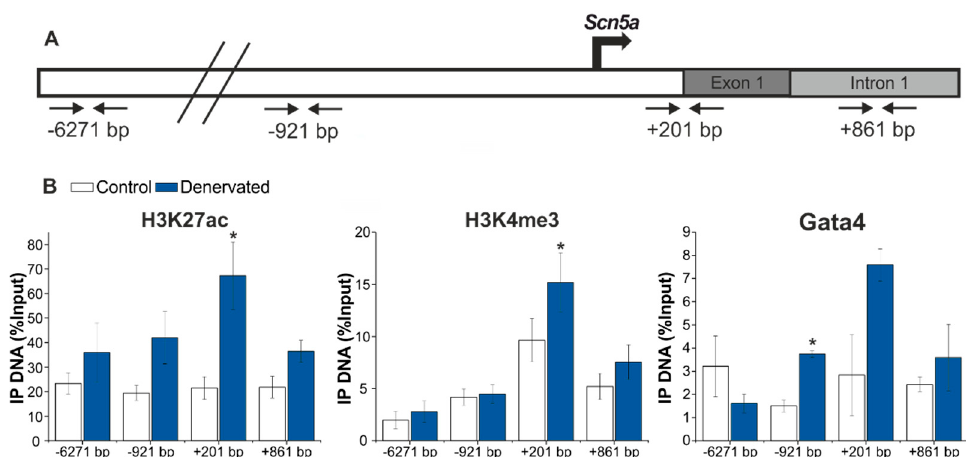
Figure 5. Enrichment of H3K27ac and H3K4me3 and binding of Gata4 near the Scn5a promoter in the denervated muscle. ( A ) Schematic view of the localization of the four primer pairs used by qPCR. Numbers indicate outermost left base pairs of amplicons. ( B ) Chromatin immunoprecipitation (ChIP) assays from control (white) and denervated (blue) samples using antibodies against H3K27ac, H3K4me3 and Gata4 and followed by qPCR. Results are shown as percentage of input (mean ± SE). H3K27ac ( n = 6), H3K4me3 ( n = 6) and Gata4 ( n = 3). Significance was analyzed with t-test ( * p < 0.05).